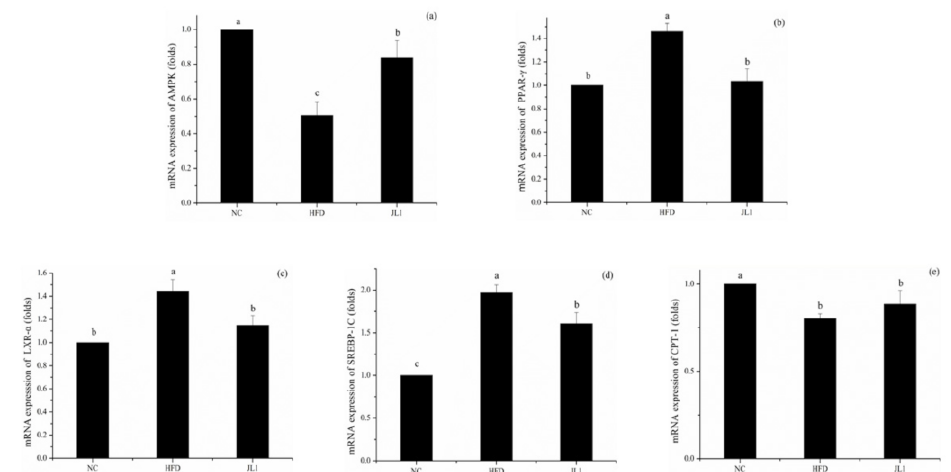
Figure 4. Effects of L. rhamnosus JL1on mRNA expression of mice liver. ( a ) mRNA expression of AMPK, ( b ) mRNA expression of PPAR- γ , ( c ) mRNA expression of LXR- α , ( d ) mRNA expression of SREBP-1C, ( e ) mRNA expression of CPT-1. Each value represents the mean of 8 mice, and error bars indicate standard deviation ( ± SD). Different letters denote significant differences between different groups of mice ( p < 0.05).